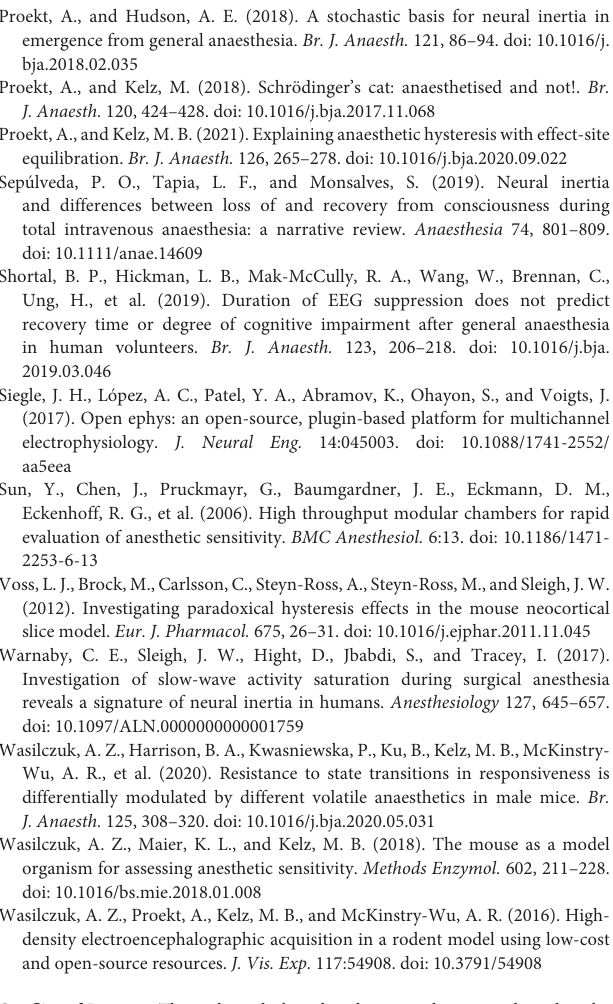
SUPPLEMENTARY FIGURE 1 | Classifier accuracy built on shuffled training data does not trend from chance over time. The accuracy of linear classifiers built from shuffled training data do not trend in any direction over time ( p = 0.4288, 2-way ANOVA), but rather remain at the chance. This demonstrates a lack of inherent directional bias of the model itself over time, suggesting trends over time seen with non-shuffled training data are